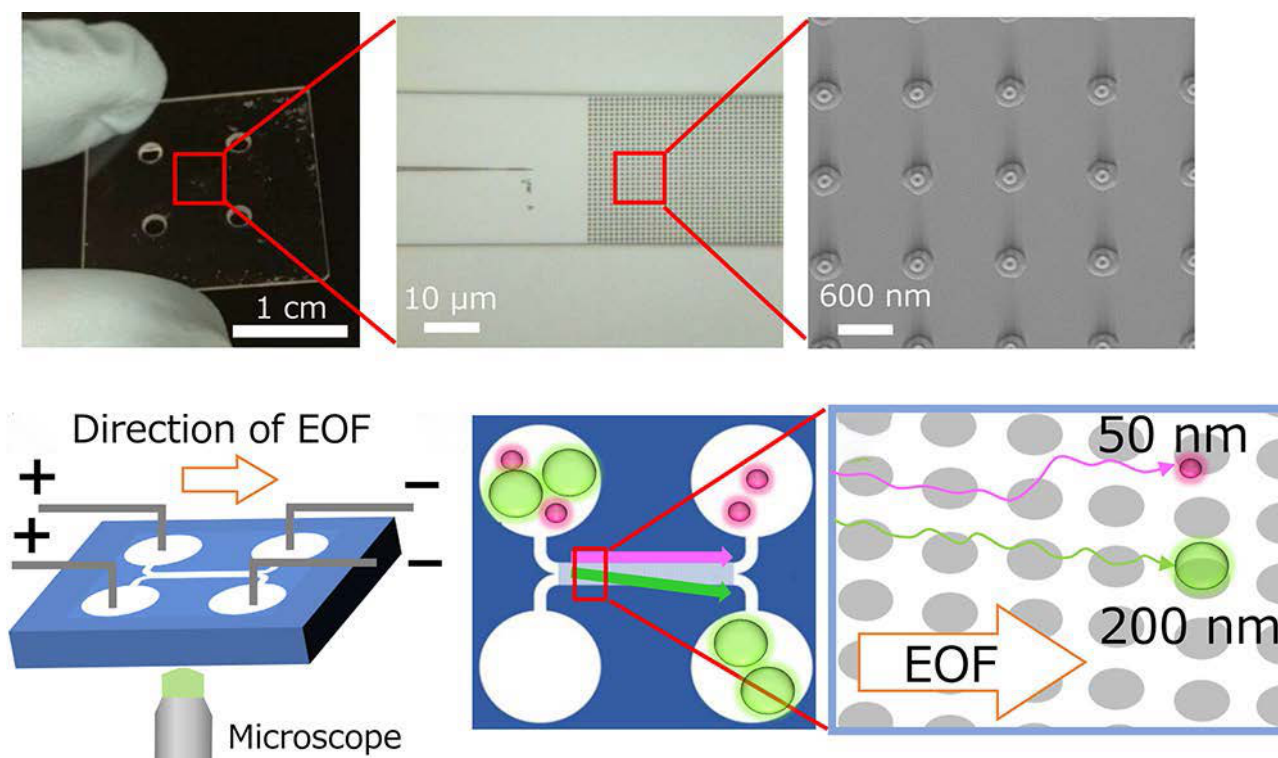
Figure 4. Schematic of a microfluidic device for exosome isolation based on DLD. Reprinted with permission [60] .